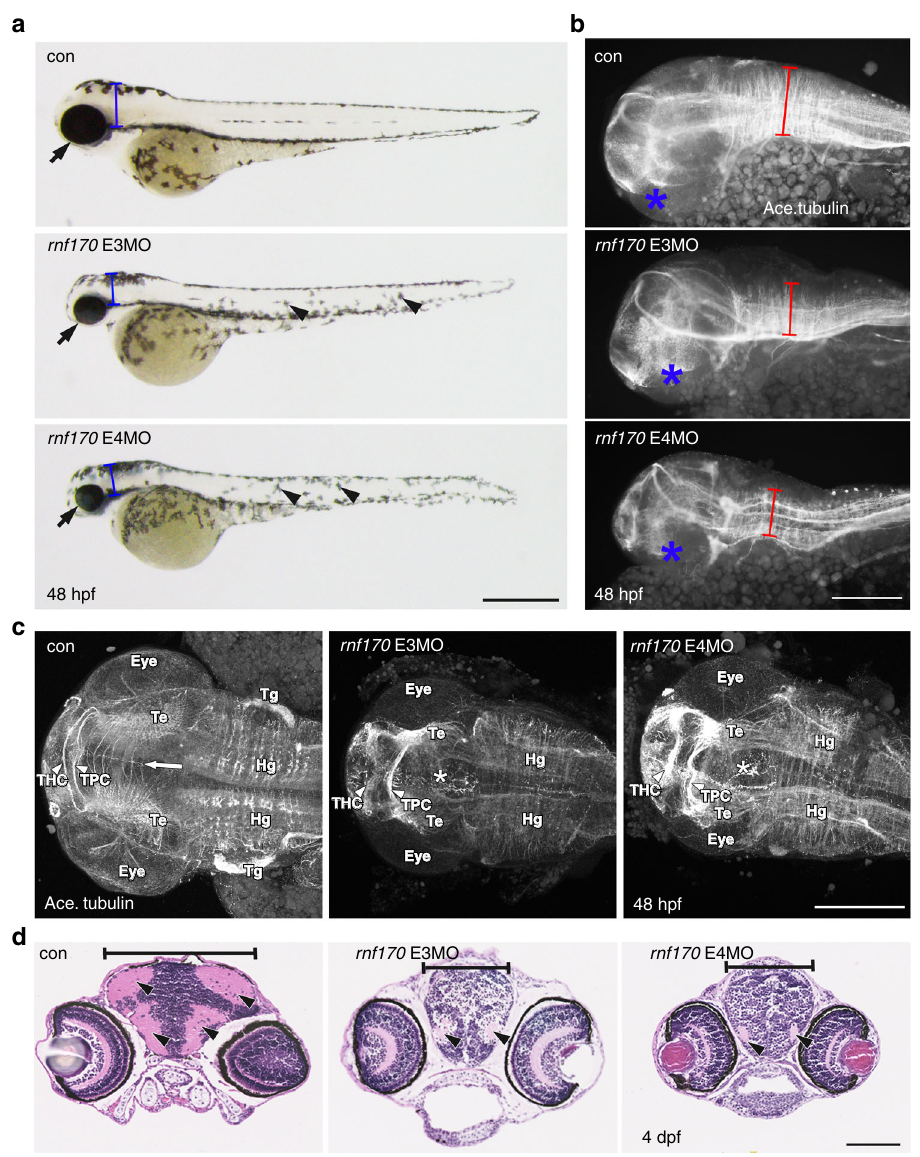
Fig. 4 MO knockdown of rnf170 results in morphological abnormalities, impaired neurogenesis, and motoneuron defects. a Representative images showing the morphology of live zebra fi sh embryos at 48 hpf injected with two different splice-blocking rnf170 antisense MOs. rnf170 morphants are characterized by a shortened body axis, micropthalmia (arrows), microcephaly (brackets), and alterations in pigmentation (arrowheads). Scale bar represents 500 µ m. b Staining for the axonal marker acetylated tubulin at 48 hpf indicates impaired neurogenesis as shown by reduced neuronal density and migration (brackets) in the developing hindbrain of rnf170 morphants, compared with control embryos. Asterisks indicate the position of the eye, scale bar represents 50 µ m. c Dorsal fl atmount images of acetyated tubulin stained embryos at 48 hpf showing loss of migrating axons across the intertectal commissure (arrow and asterisks), reduction of arborization in the tectum (Te), and thickening of the tracts of the habenular commissure (THC) and tracts of the posterior commissure (TPC) (arrowheads). Scale bar 200 µ m. The eye, trigeminal glia (Tg) and hindbrain glia (Hg) are given as further landmarks. d Aberrant eye and brain development was observed in wax sections of rnf170 morphants at 4 dpf stained with H&E. Reduction of cranial width (brackets) and ventricular cavities was apparent (arrowheads). Scale bar represents 100 µ